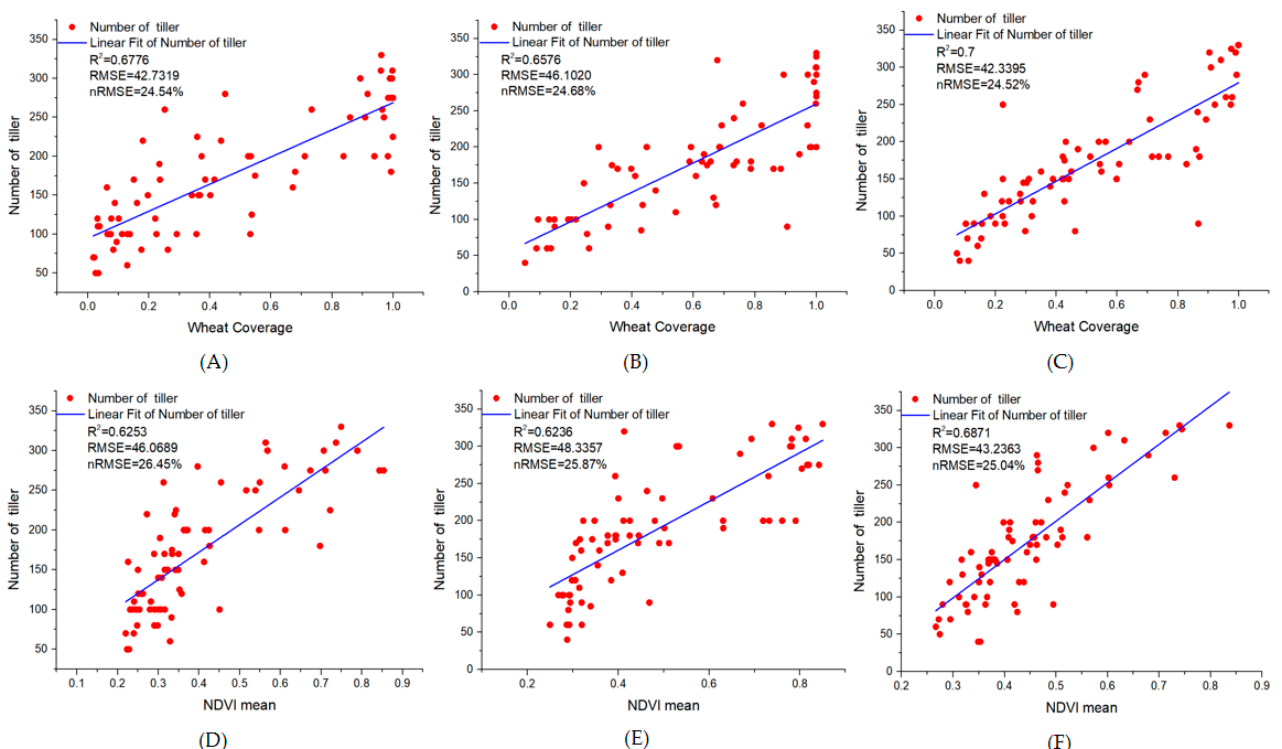
Figure 10. Unitary linear regression models for winter wheat variety 1 ( A , D ), variety 2 ( B , E ), and variety 3 ( C , F ) of number of tillers and wheat coverage ( A , B ), and NDVI ( D , E ).